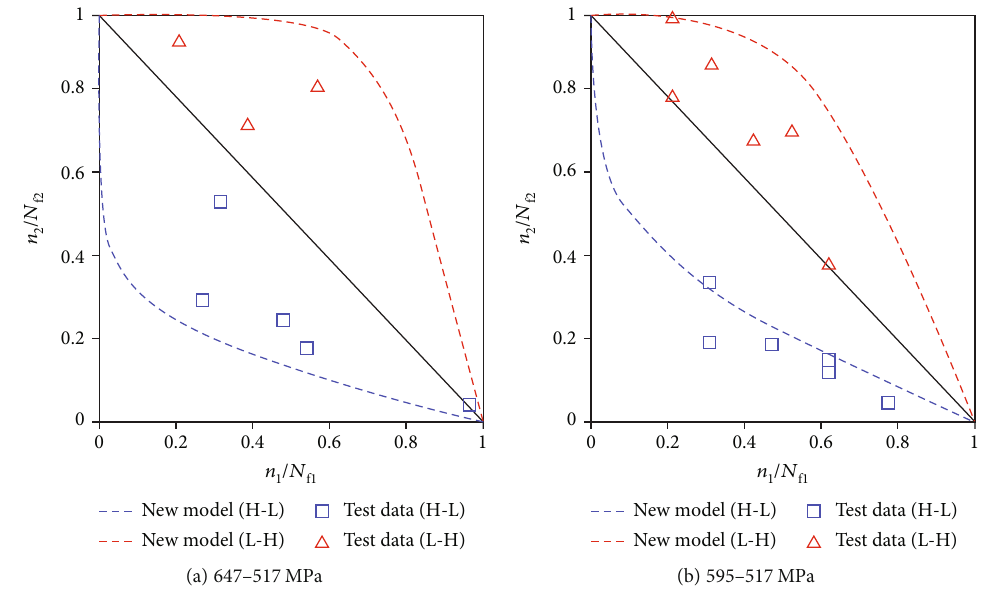
Figure 7: Relations between cycling ratios of the Ti-6Al-4V titanium alloy under two-level cyclic loading.